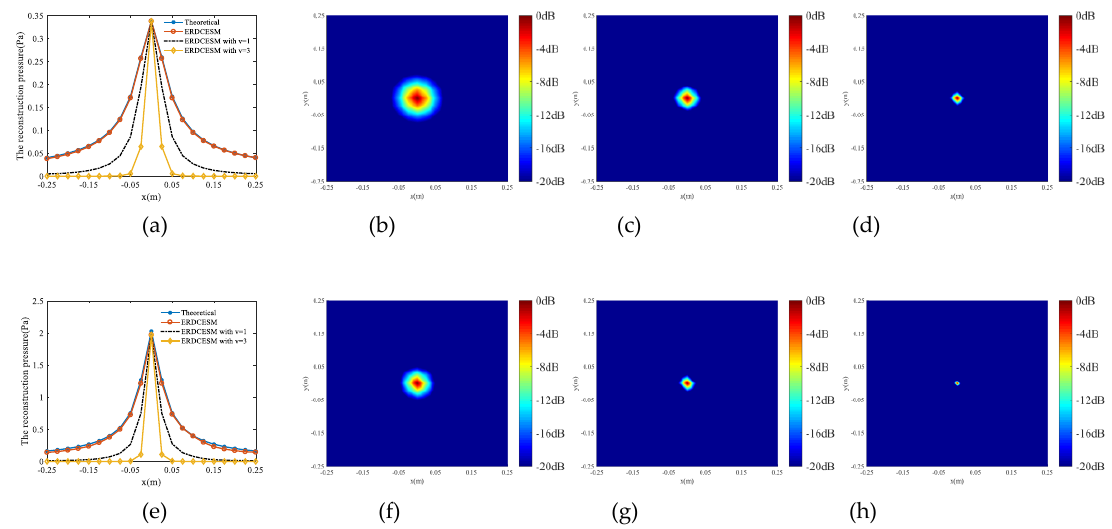
Figure 5. Pressure distributions of ( a ) the sound pressure at 500 Hz, ( b ) ERDCESM with ν = 0 at 500 Hz, ( c ) ERDCESM with ν = 1 at 500 Hz, ( d ) ERDCESM with ν = 3 at 500 Hz, ( e ) the sound pressure at 2000 Hz, ( f ) ERDCESM with ν = 0 at 2000 Hz, ( g ) ERDCESM with ν = 1 at 2000 Hz and ( h ) ERDCESM with ν = 3 at 2000 Hz for a single source.